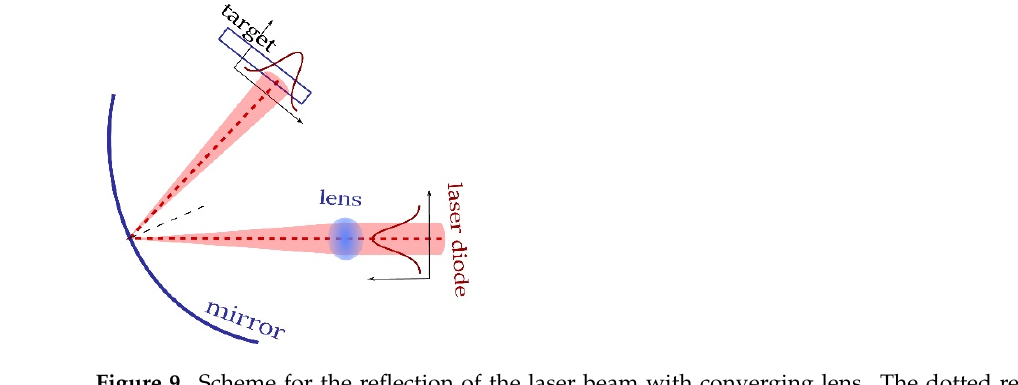
(13) Equation (13) is an alternative expression for the slope error with respect to Equation (7). In this case it is completely related to measured variables. Combining Equations (10), (12), and (13), the reconstruction can be performed com- pletely and both the coordinates and the slope error can be calculated. For this aim, a MATLAB ® routine is implemented and the solution of the system of equations is obtained numerically. Uncertainties are estimated with a Monte Carlo method. 5. Measurement of the Spot Position To measure the spot position on the target, usually a centroid-based method is uti- lized [12,14]. The centroid of a plane figure is the arithmetic mean position of all the points in the figure. The image is converted into a binary image, namely an image in which the pixel intensity can have a value of 0 or 1. To obtain a binary image, a threshold condition must be imposed. However, this technique can have some drawbacks. First of all, a com- plete image of the spot has to be provided, otherwise the calculation will lead to a huge error on the spot position. This could occur in the present experimental setup, since the target is a few centimeters wide (to keep small the hidden region as shown in Figure 5) and the spot on the target is about 10 mm wide in one direction. Furthermore, the centroid calculation can be affected by the natural noise on the pixel intensity due to scattering on the spot and/or on the mirror that can affect the shape of the binary image. For this reason, it is impossible to define a suitable uncertainty on the calculation made with this method. A new technique for the measure of the on-screen point (OSP) of the laser spot is developed. It is based on the variation of the pixel intensity and is not as purely geometric as the centroid method. As shown in Figure 4a, a lens is placed in front of the laser diode. The lens is needed to minimize the laser spot on the mirror; however, on the other side it enlarges the laser spot dimension on the target. This permits to have a well-defined be- havior for the pixel intensity on the various pixel positions. The position of the focus cen- ter can be calculated as the maximum of the pixel intensity. In fact, the profile of the laser intensity is usually bell-shaped with its maximum located in the center of the beam. Since